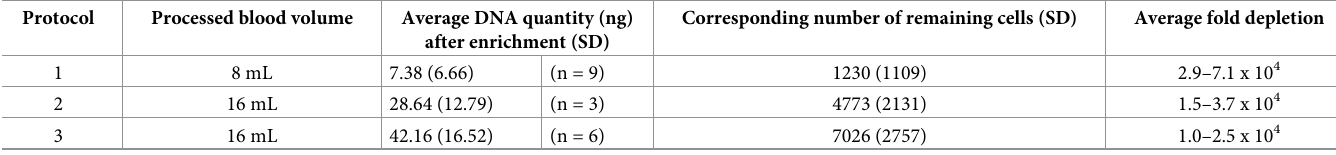
Table 1. Overview of the Metacell 1 performance. For each protocol, the average DNA quantity after enrichment, the corresponding number of remaining cells, and the average fold depletion is calculated. Protocol Processed blood